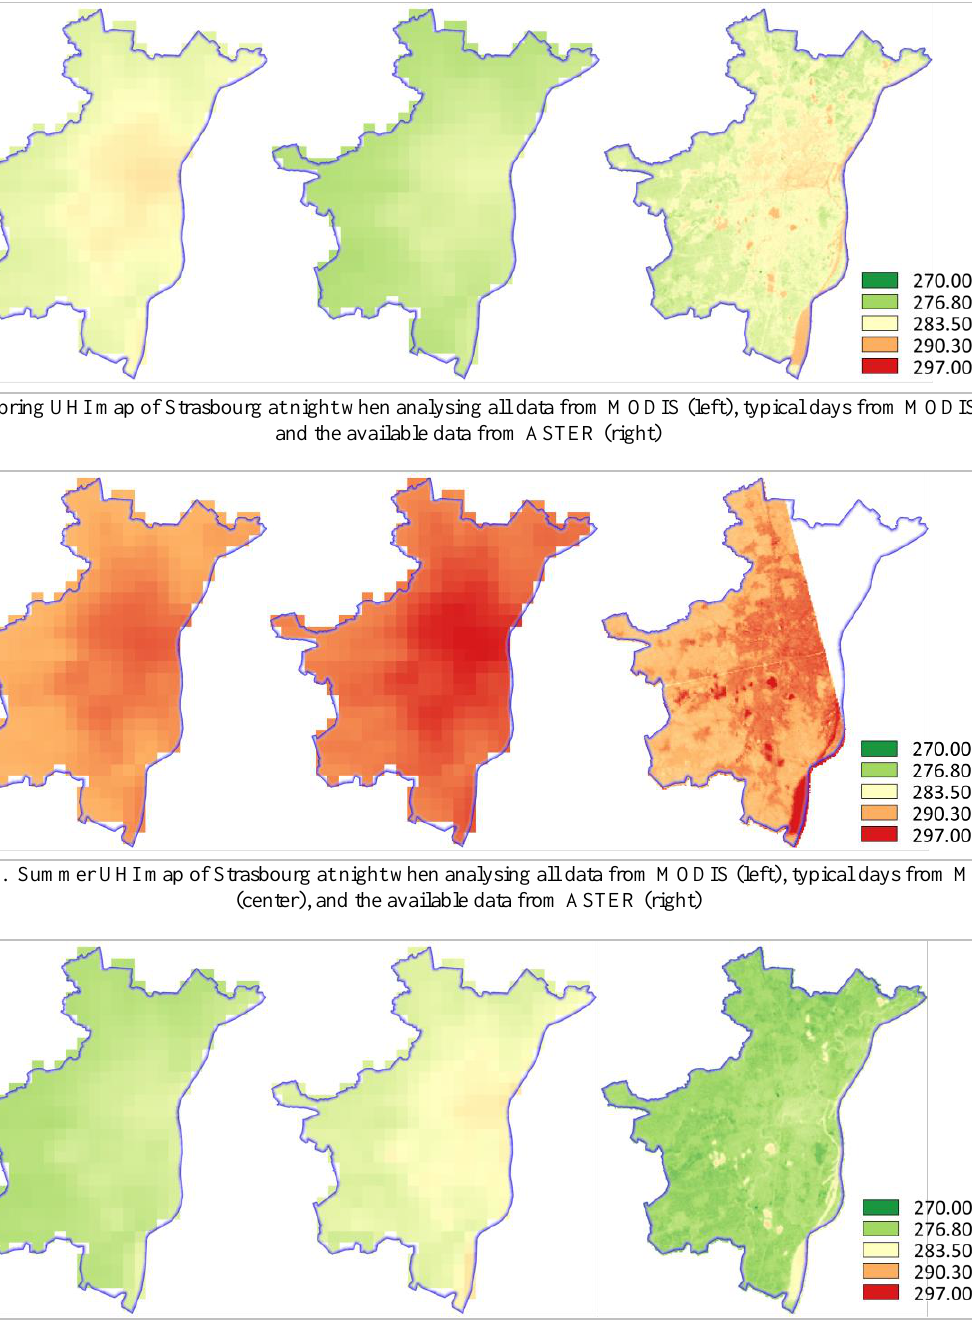
Figure 13 . Autumn UHI map of Strasbourg at night when analysing all data from MODIS (left), typical days from MODIS (center), and the available data from ASTER